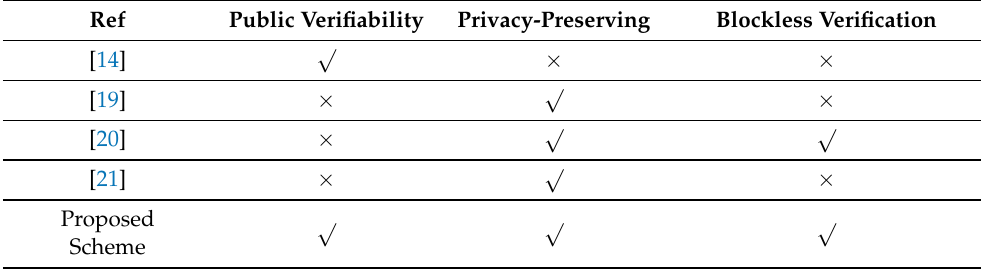
Table 2. Comparison of desirable